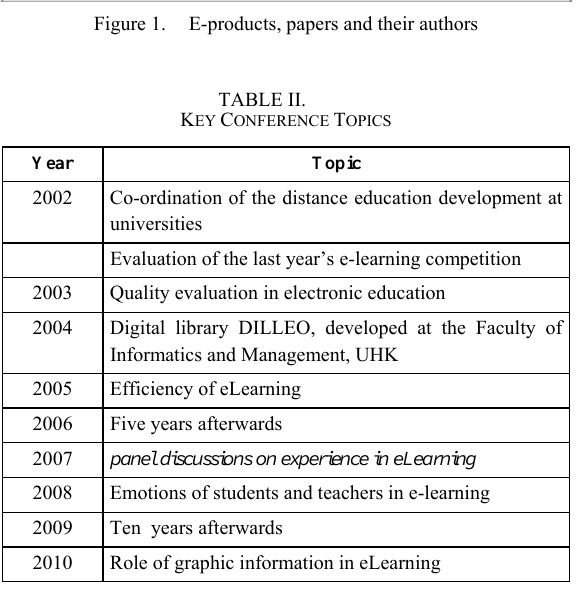
TABLE III. T YPES OF C